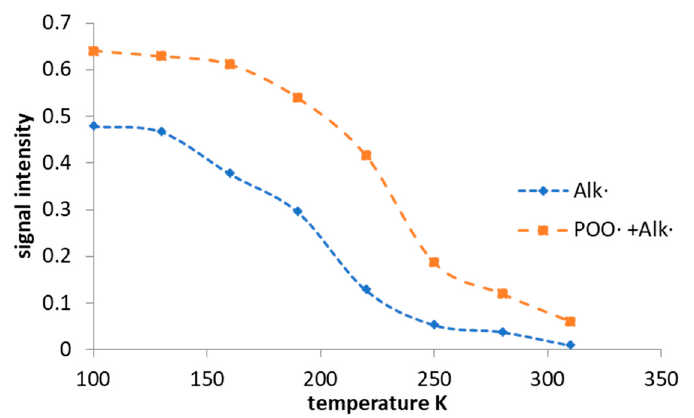
Figure 6. Intensities of the (POO • + Alk • ) and Alk • signal components in AO-protected, unaged XLPE (52 kGy, low-rate) probe-irradiated in air in different temperatures at measurement. Dashed lines are guides for the